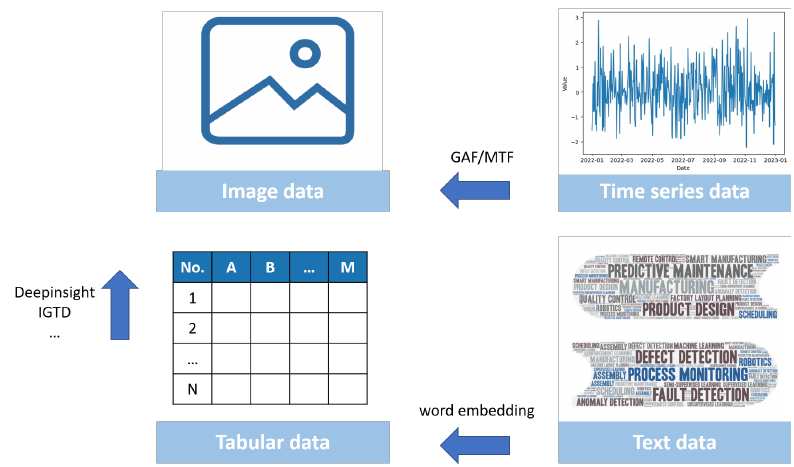
Figure 6. Data types used in ML and their